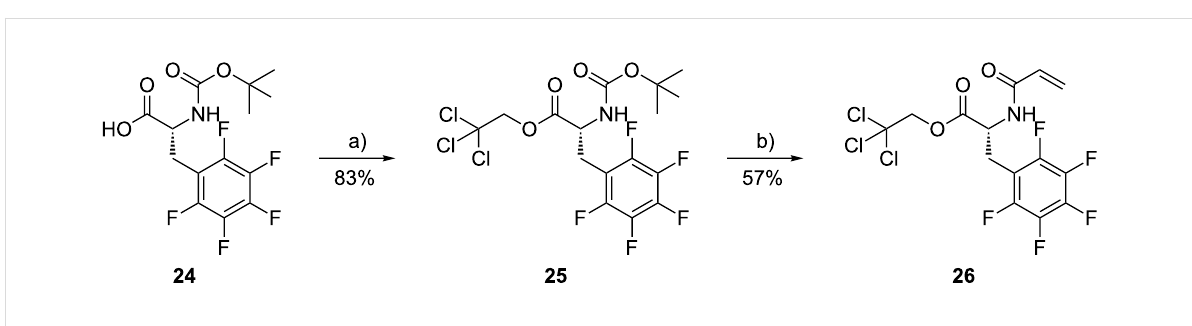
Scheme 3: Synthesis of the pentafluorophenylalanine building block 26 . Reagents and conditions: (a) pyridine, trichloroethanol, DCC, CH 2 Cl 2 , 0 °C, 20 h; (b) 1. TFA, rt, 2 h; 2. NEt 3 , acryloylchloride, CH 2 Cl 2 , 0 °C, 7